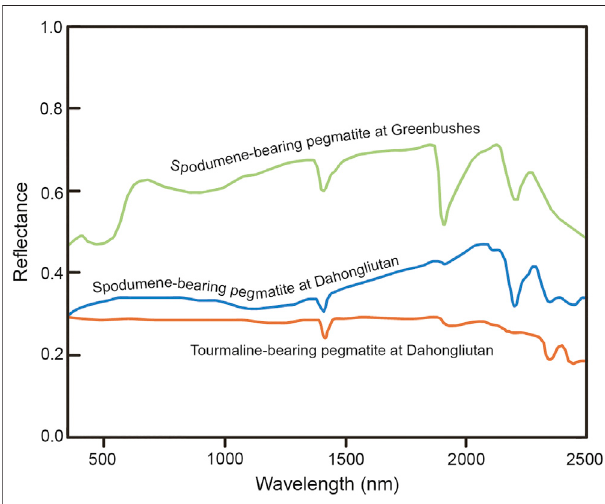
FIGURE 2 | Spectrum curve for spodumene-bearing pegmatites at Greenbushes (Australia) and Dahongliutan, and tourmaline-bearing pegmatites at